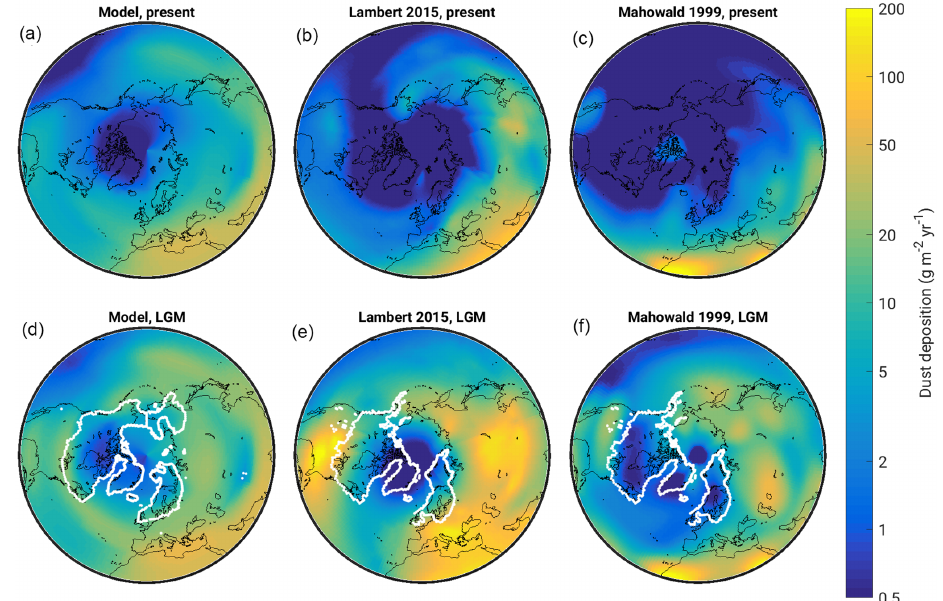
Figure 3. Modelled annual dust deposition compared to observations for the present day (a–c) and reconstructions for the Last Glacial Maximum (d–f) . The model results ( a , d ) are compared to data from Lambert et al. (2015) ( b , e ) and Mahowald et al. (1999) ( c , f ). The dataset of Mahowald et al. (1999) does not include glaciogenic dust. For the LGM, the white lines indicate the modelled (d) and reconstructed ( e , f ; Tarasov et al., 2012) extent of the ice sheets.